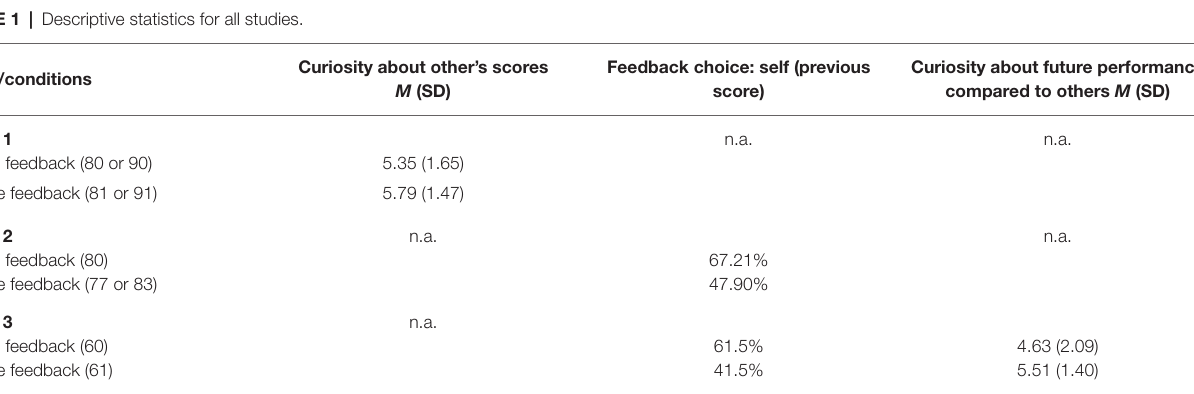
TABLE 1 | Descriptive statistics for all